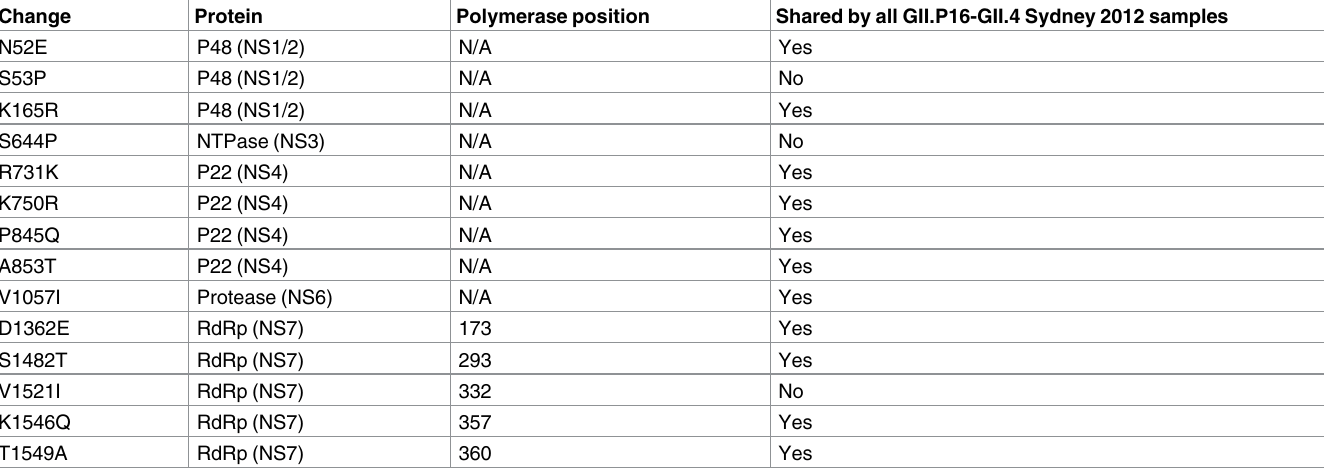
Table 1. Sites in ORF1 that change leading to the GII.P16-GII.4 Sydney 2012 clade. Change Protein Polymerase position Shared by all GII.P16-GII.4 Sydney 2012 samples